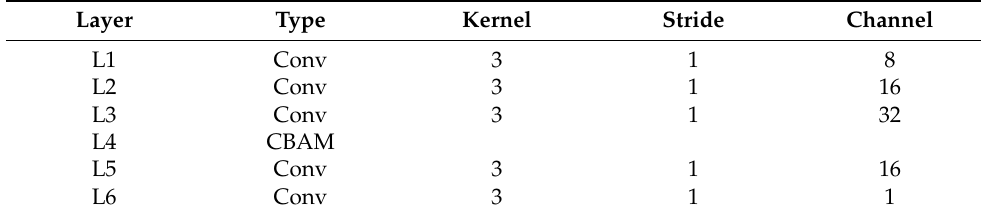
Table 1. Details of shallow feature extraction network. Layer